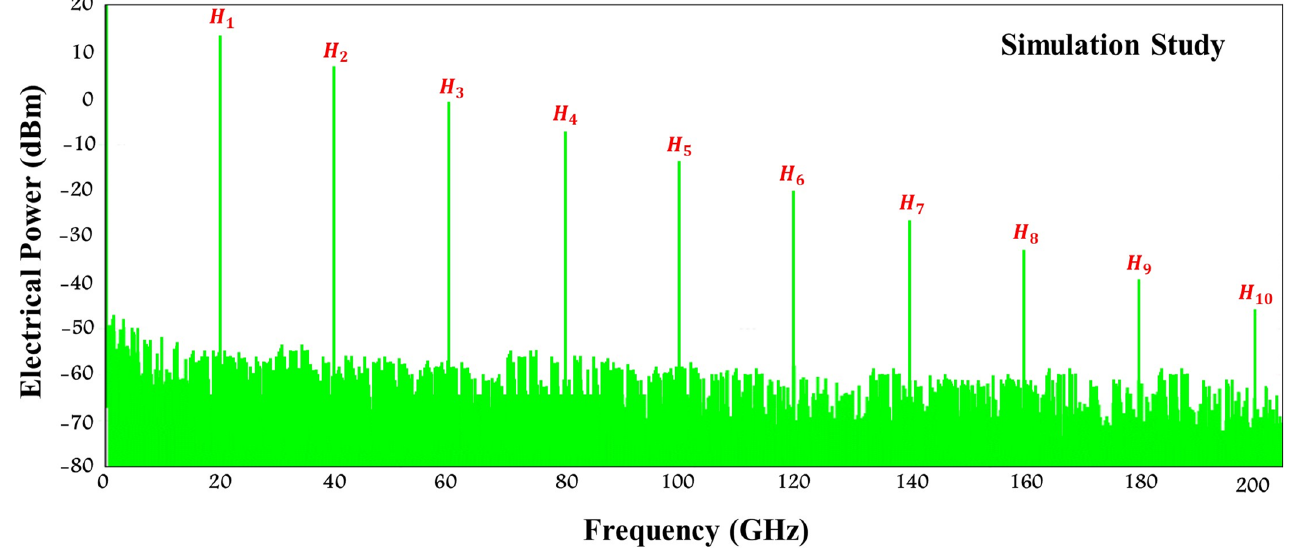
Figure 7. Electrical spectrum results successfully attained by the VPI simulator for the “AND” gate mechanism using the di ff erential modulation concept.